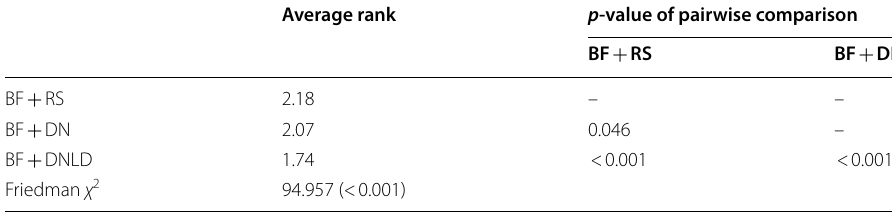
RS, BF DN, and BF + +